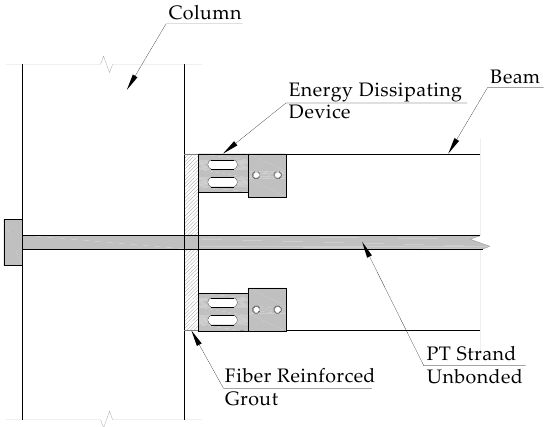
Figure 27. Proposed precast post-tensioned beam–column connection [49]. Qian et al. 2020 [51] tested unbonded post-tensioned precast concrete frames with no mild steel for a sudden column removal scenario. The test indicated that the frame achieved required a load redistribution capacity to mitigate progressive collapse. Column removal duration in the test was 0.008 s and 0.005 s, satisfying the DoD requirement that the column removal duration should be less than 1/10 natural period of vibration. Weights were attached to the beams, which acted as gravity loads. The test setup accurately repli- cated the sudden column removal scenario due to blast load. However, the flooring sys- tem was not considered in the test. Yang et al. 2021 [21] performed a test on a self-centering single-bay two-story hybrid frame. This consisted of an RC column with unbonded PT steel bars and steel concrete hybrid beams with four unbonded PT strands. Self-centering was provided by PT steel, and energy dissipation was provided by web friction devices at beam ends. Two frames with PT steel and one frame without PT steel were examined. The PT frames performed better than the non-PT frame in terms of bearing capacity, ductility ratio, and self-center- ing capacity, with values 88%, 62%, and 272% higher, respectively. Energy dissipation was better in PT frames as compared to the non-PT frame specimen. The beam column con- nection in the proposed frame contains too many components, including column plates,